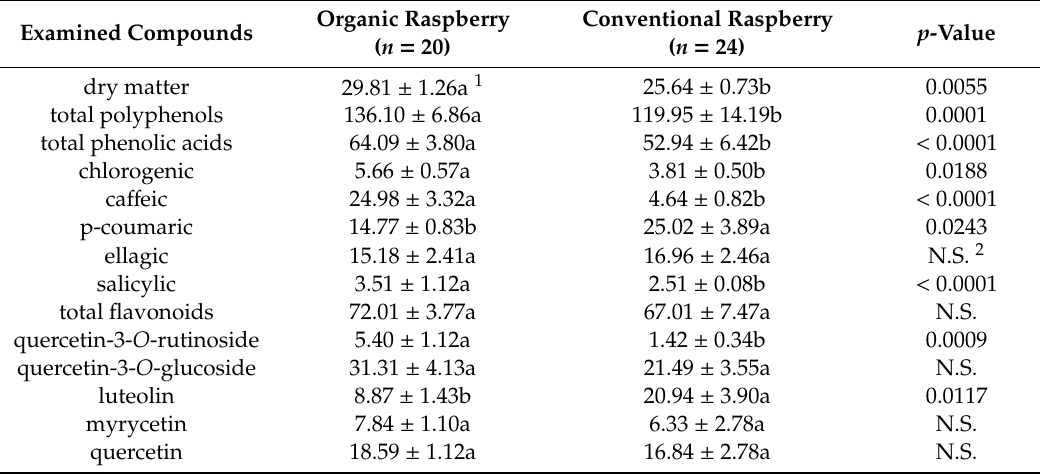
Table 2. The content of dry matter in (g 100 g − 1 FW) and polyphenols (mg 100 g − 1 FW) in examined raspberry leaves depending on cultivation system. Data are presented as the mean ± SE with ANOVA p -value.